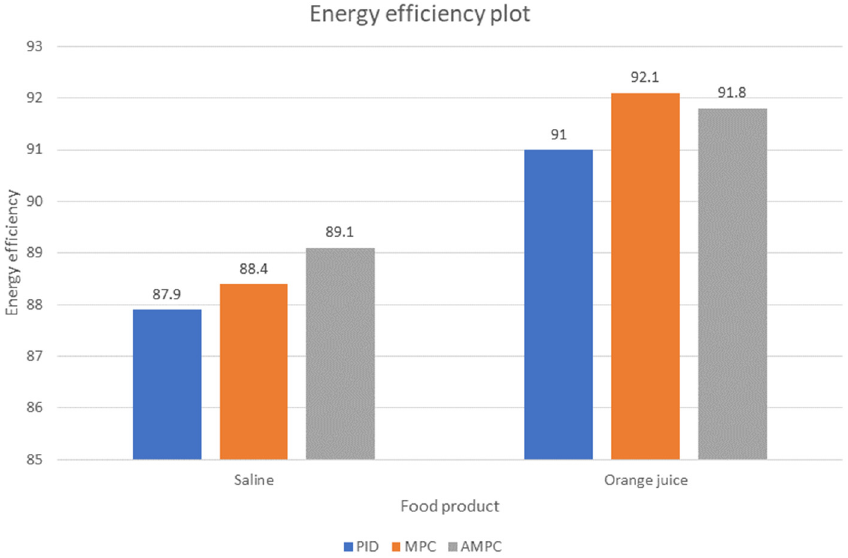
Figure 8. Energy efficiency plot of the ohmic heater for different controllers.